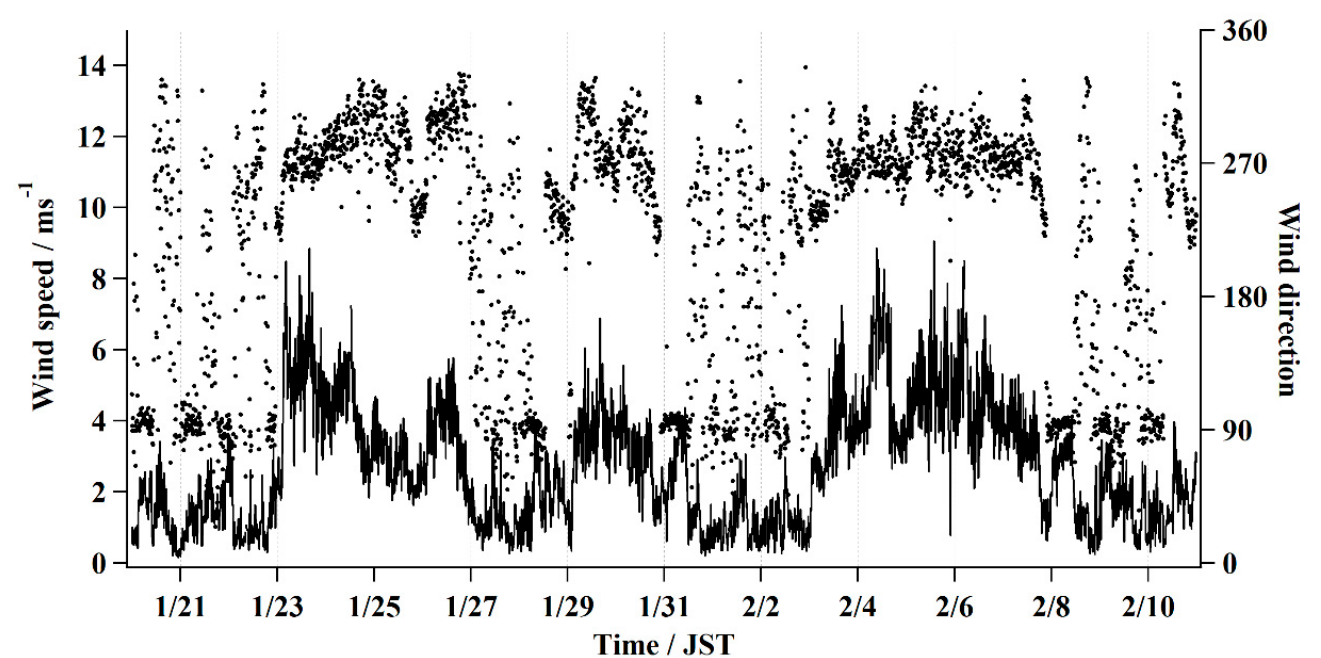
Figure 5. Wind speed (solid line) and wind direction (dots). Table 1. Average values of gas, meteorological, and PM data for Groups A and B.